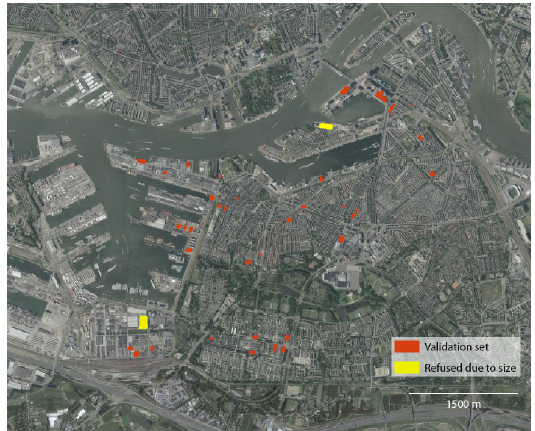
Figure 9. Illustration showing the buildings south of the Maas river in Rotterdam selected for the validation set.